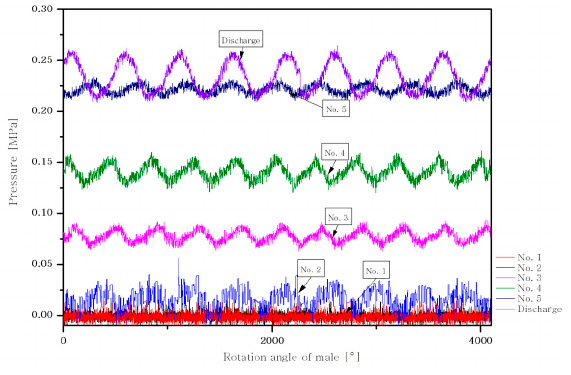
Figure 13. Volume rendering of the velocity distribution according to the angle of rotation.